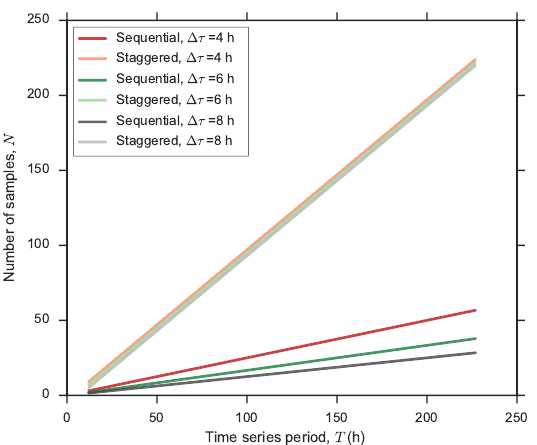
Figure 9. The number of filter samples N of length 4, 6, and 8h required to measure time series of period T h sequentially and by staggering the samples at an interval δτ of 1h. The number of se- quential samples is given by T/(cid:49)τ and the number of staggered samples is given by (T − (cid:49)τ + 1 )/δτ